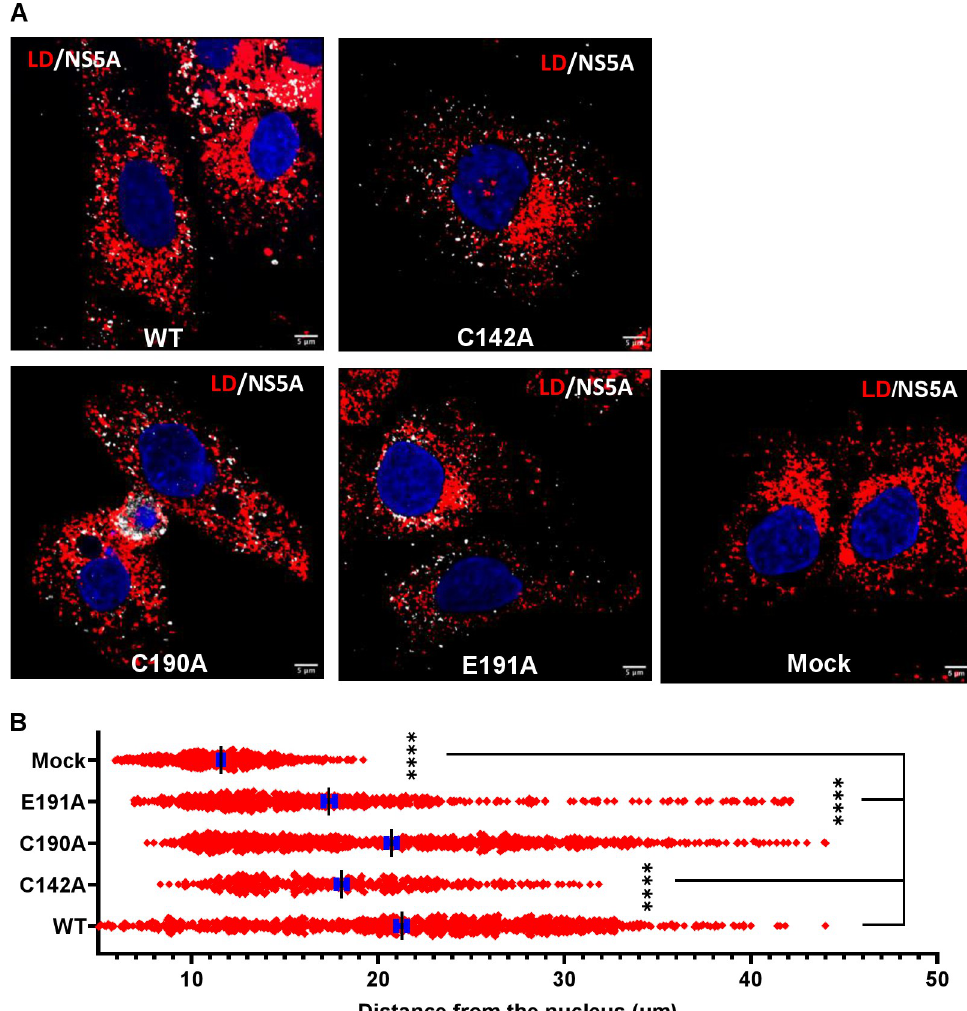
Fig 5. Analysis of LD distribution. (A) Cells were stained at 72 hpe with sheep anti-NS5A (white), BODIPY 558/ 568-C12 (red) and DAPI. ( B) Distances of LDs from the nuclear membrane were evaluated using the Analyze Particles module of Fiji. 10 cells were analysed for each sample. Significant differences from WT denoted by ���� (P < 0.0001).